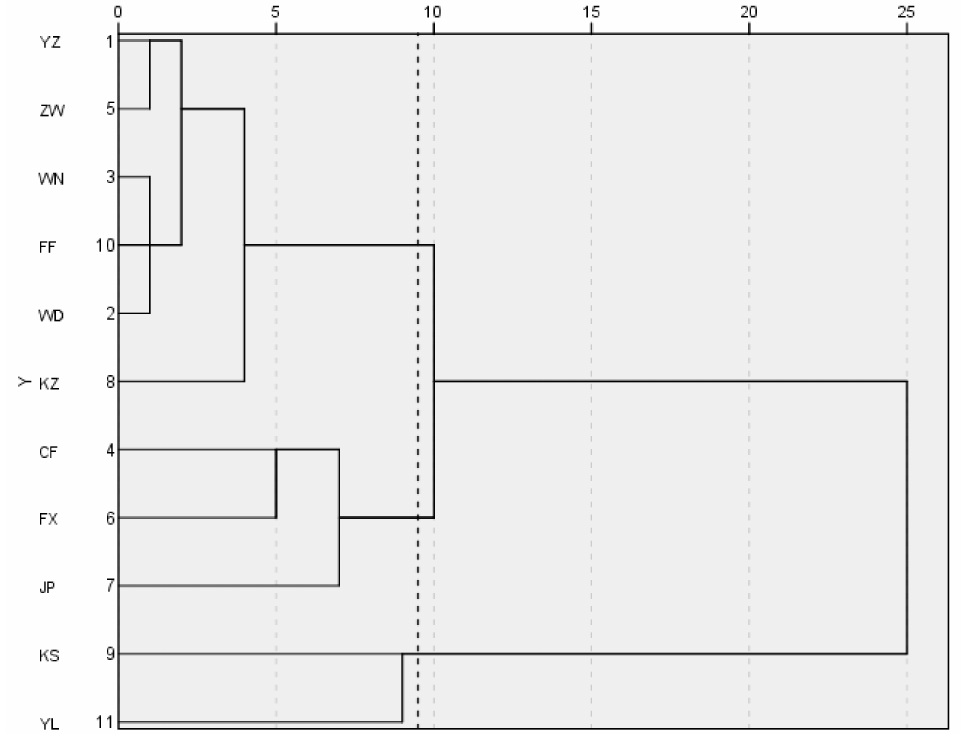
Figure 2. Clustering results of seed oil indexes of A. truncatum from different areas. The natural forest production areas: Horqin Right Wing Middle Banner (YZ), Wudantala Forest Farm (WD), Wengniuteqi Pine mountain Forest Farm (WN) and Chifeng city (CF) of Inner Mongolia, Zhangwu (ZW), Fuxin (FX), Jianping (JP) and Kazuo (KZ) city of Liaoning, Kashi (KS) city of Xinjiang, Fufeng (FF) and Yangling (YL) city of